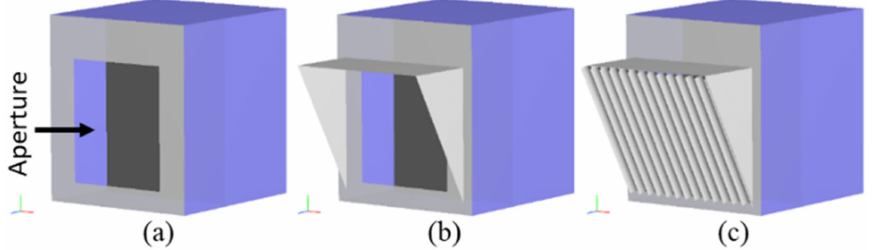
Figure 3. Baseline aperture ( a ), with aperture shroud/hood ( b ), and with hood cover and quartz half-shell tubes ( c )